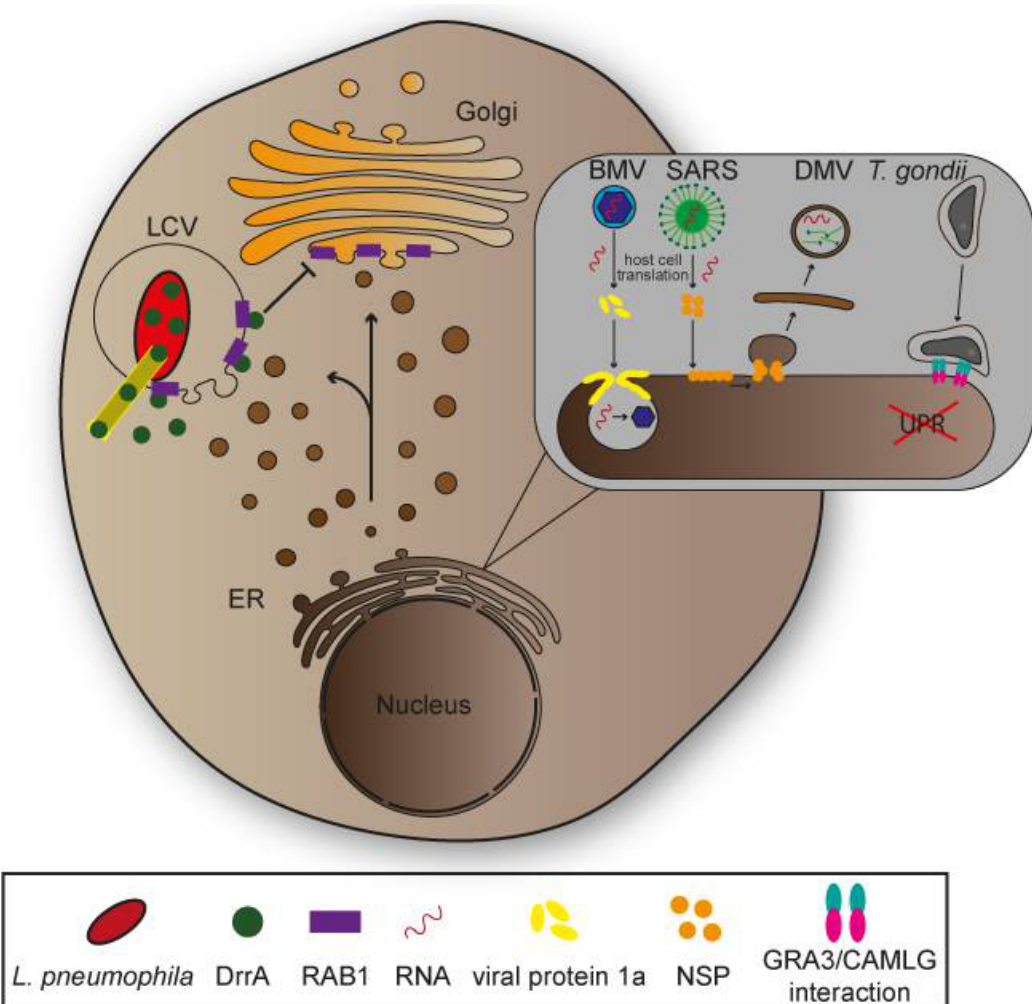
Figure 3. Manipulation of endoplasmic reticulum (ER) by intracellular pathogens. Legionella pneumophila recruits small GTPase RAB1 to the Legionella -containing vacuole (LCV) membrane through T3SS-secreted effector protein DrrA resulting in redirection of vesicular transport between the ER and the Golgi. L. pneumophila thereby ensures nutritional supply for bacterial replication. Brome mosaic virus (BMV) and severe acute respiratory syndrome coronavirus (SARS) exploit the host cell protein machinery to produce viral proteins. BMVs viral protein 1a induces invaginations of ER membranes ultimately creating vesicular spherules suitable for viral replication. SARS non-structural proteins interact with ER membranes and lead to the formation of double membrane ER vesicles (DMV) that promote viral replication. T. gondii associates with the ER membrane through interaction protein GRA3 and the ER receptor calcium-modulating ligand (CAMLG) which might support manipulations by T. gondii such as inhibition of the unfolded protein response (UPR). As host cell regulators for vesicle and membrane transport interact with GTPases RAB1, SAR1 and ARF1, these represent effective targets for translocated effector proteins.